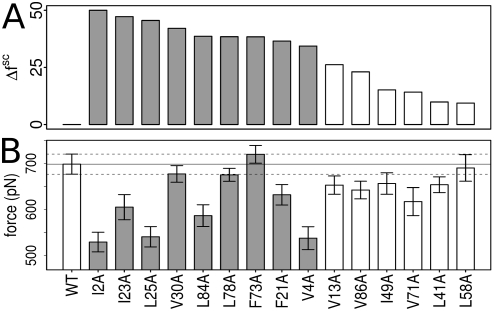
Forces needed for transition into the intermediate state measured for a selected set of in silico mutations.(A)  values for the mutated residues sorted in descending order. The nine residues with highest , for which decreased rupture forces are expected, are colored gray. (B) Rupture forces observed for transition into the intermediate. The majority of the nine residues with highest  shows a significant decrease in rupture forces comparing to the wild-type (WT), while residues with significantly lower  show less impact onto rupture forces upon mutation. The overall decrease comparing to the WT and to the six negative controls is statistically significant (p<0.01 and p<0.03, respectively, student's t-test on cumulative rupture force data. For individual p-values, see Table S1).